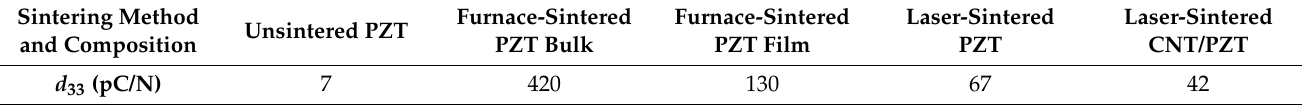
Table 5. Piezoelectric coefficient